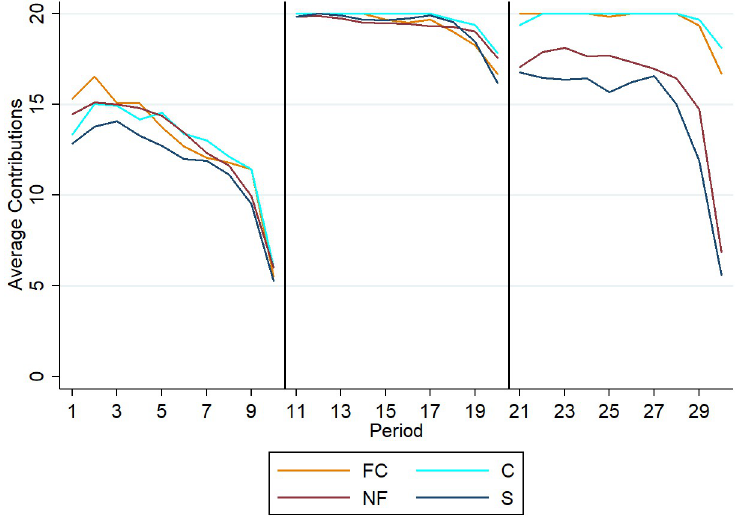
Fig 2. Average contribution rates in all blocks for respective treatments. Periods 1–10 constitute block one, 11–20 block two, and 21–30 block three